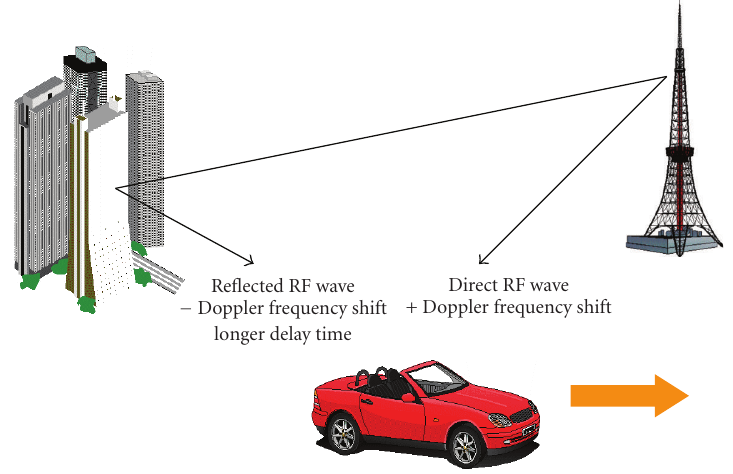
Figure 1: Problems in mobile reception.